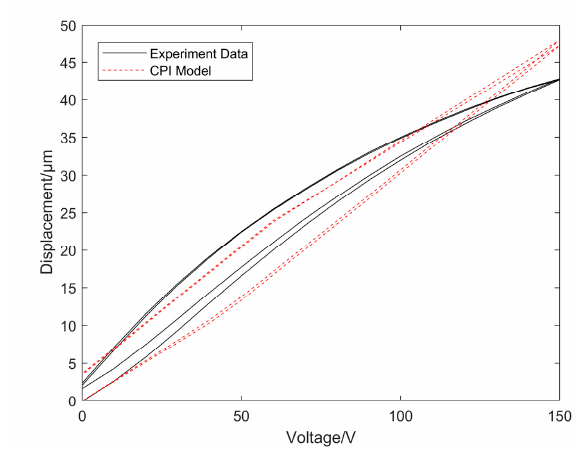
Figure 19. Hysteresis feature modeling of CPI model.